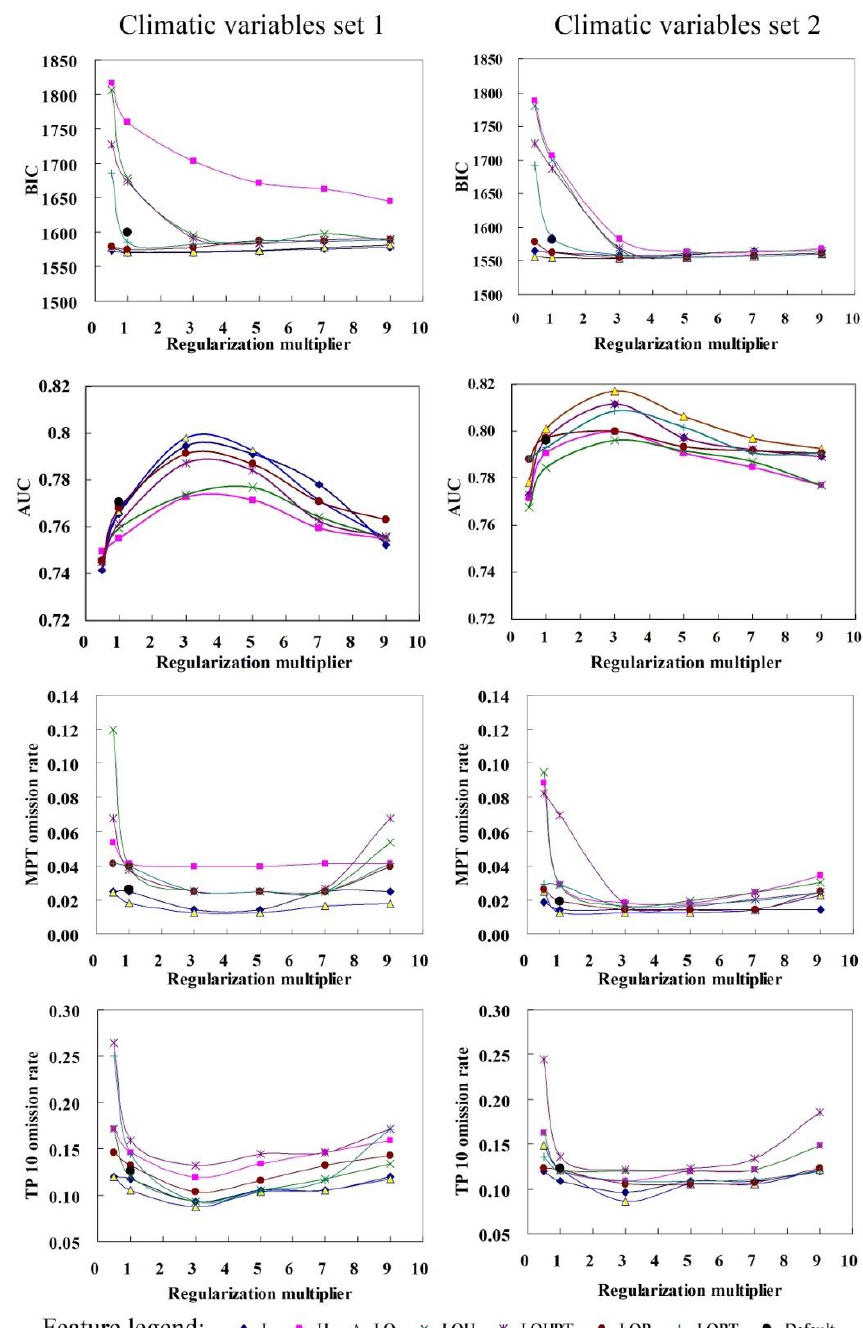
Figure 3. Performance statistics for models of tomato potato psyllid (TPP) distribution built with various combinations of regularization multiplier, feature class and climatic variables. (Feature abbreviations: L , linear; Q , quadratic; P , product; H , hinge; T , threshold).